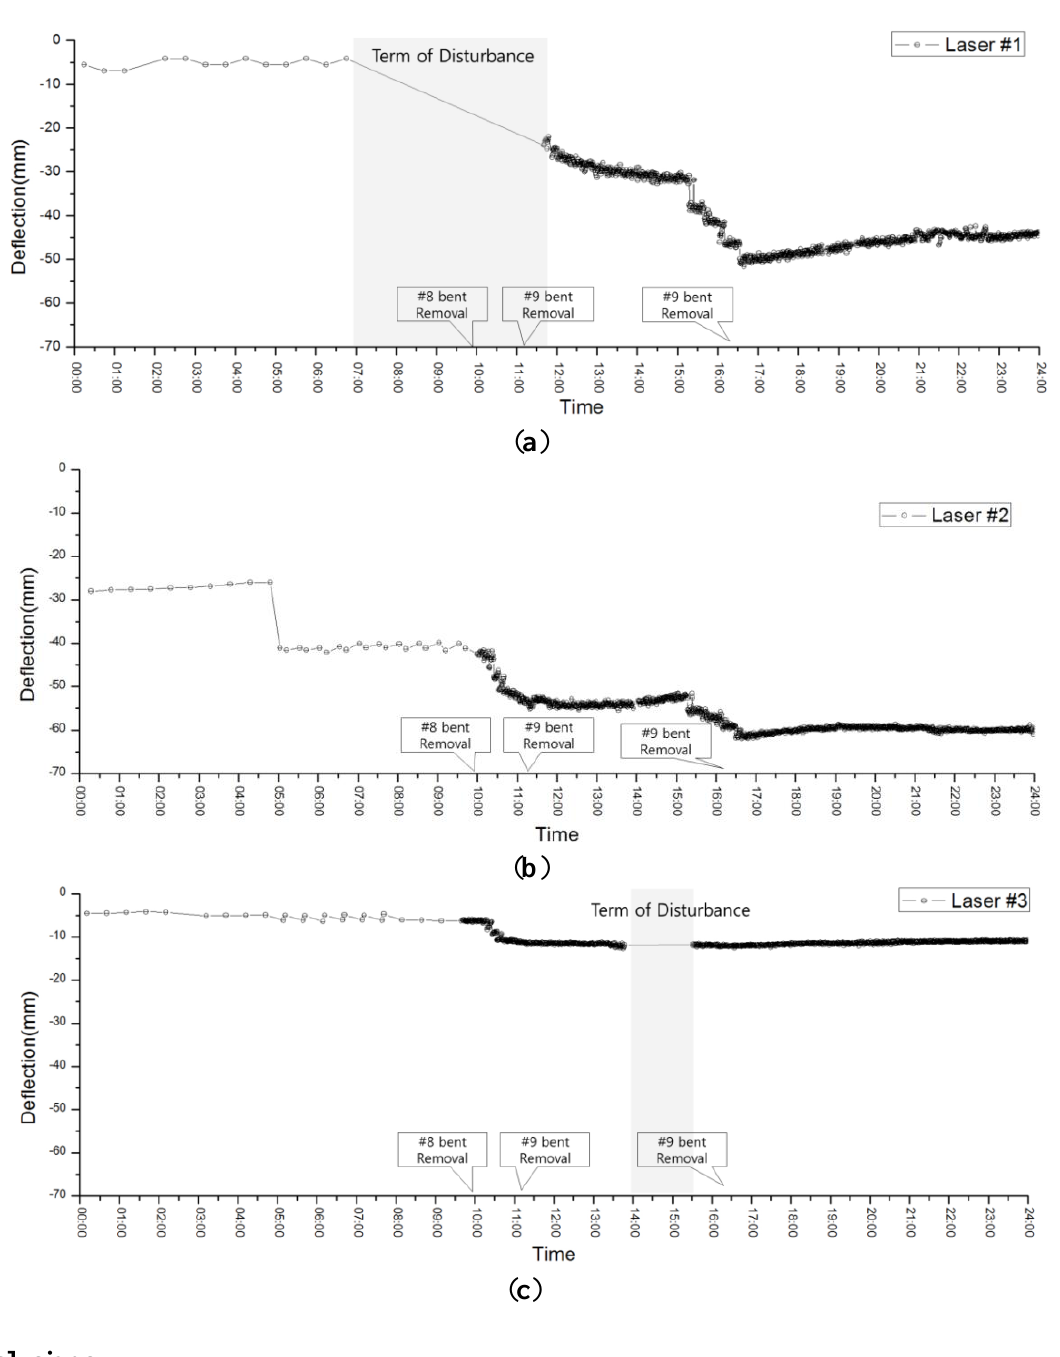
Figure 16. Measured deflection on April 25: ( a ) point 1, ( b ) point 2, and ( c ) point